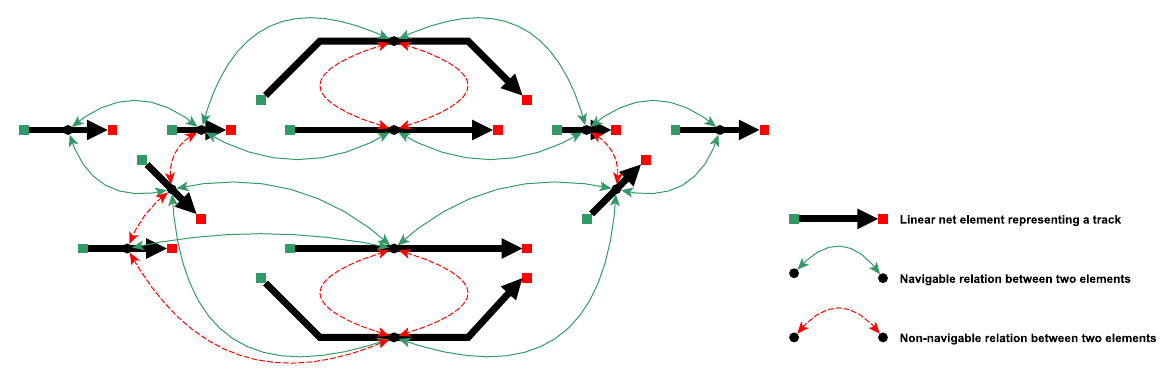
Figure 1. An application of the RailTopoModel principles on an example of a railway station with five simple turnouts and one single slip modelled by the means of positioned net